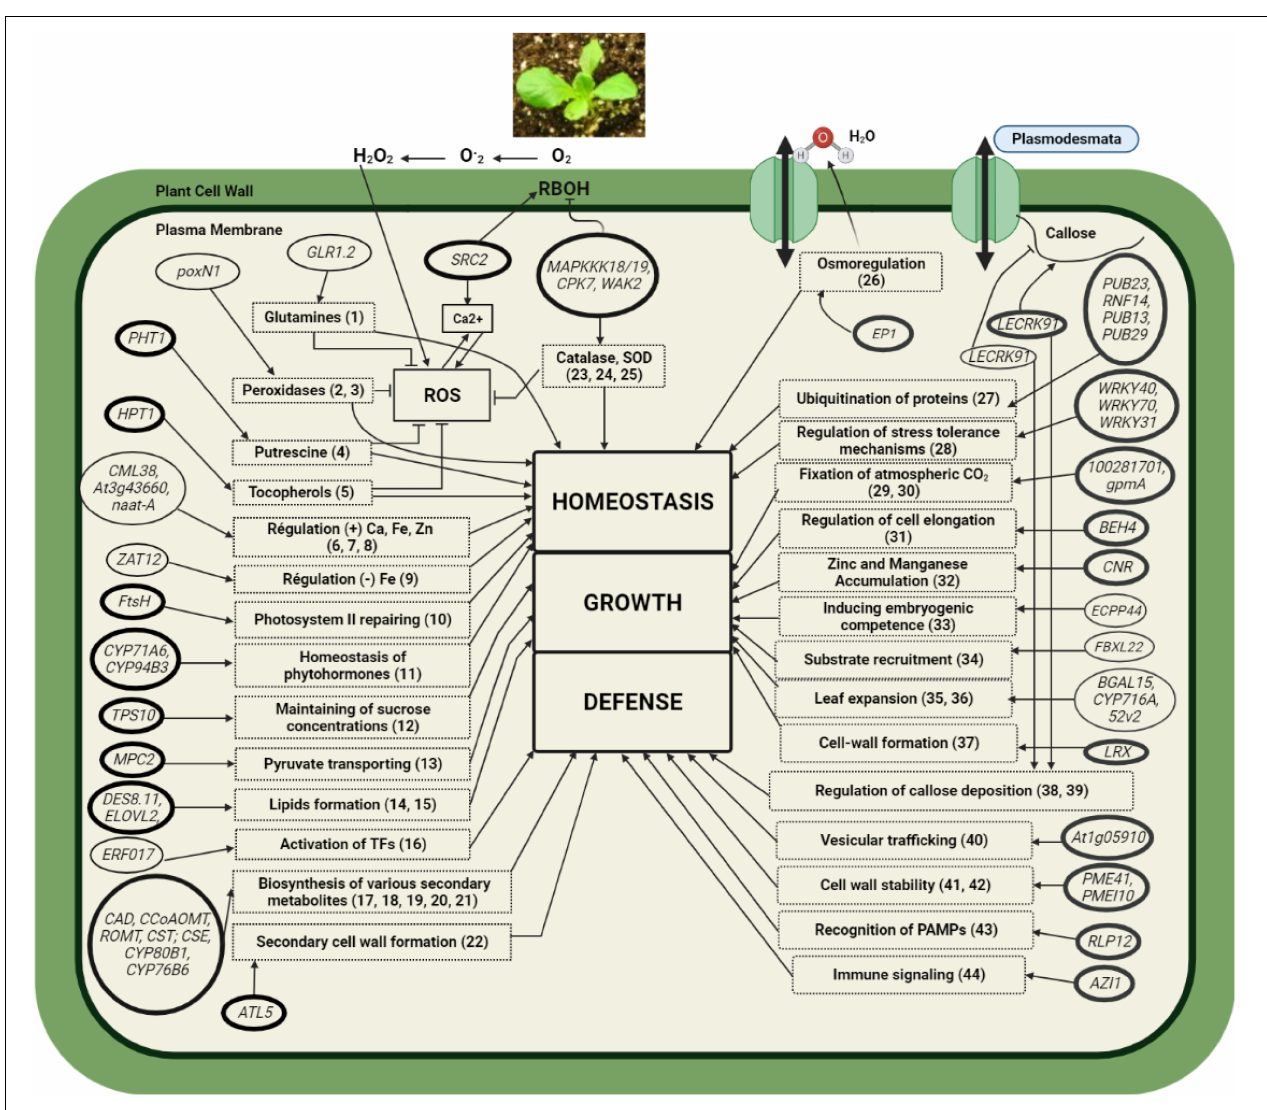
FIGURE 6 | Representative model of the regulation mechanisms induced in lettuce by the preharvest application of hormetic doses of UV-C and inoculation with the pathogen Xcv . Thick-bordered rectangular boxes: Physiological (or biological) processes; dashed rectangular boxes: Function or molecules associated with genes as reported in the literature. Thin-bordered ellipses: genes affected by UV-C alone; thick-bordered ellipses: genes affected by UV-C + Xcv infection. The pointed arrows indicate activation reactions and the blunt arrows indicate inhibition reactions. The numbers in brackets in the rectangular boxes represent the reference source(s). (1) Cheng et al. (2018); (2) Kim et al. (2007); (3) Wang et al. (2016); (4) Pushpa et al. (2014); (5) Savidge et al. (2002); (6) Lokdarshi et al. (2016); (7) Gollhofer et al. (2014); (8) Cassin et al. (2009); (9) Le et al. (2016); (10) Kato and Sakamoto (2018); (11) Yan et al. (2016); (12) Lunn et al. (2014); (13) Shen et al. (2017); (14) Doan et al. (2009); (15) Nayeri and Yarizade (2014); (16) Dey and Vlot (2015); (17) Zhang and Liu (2015); (18) Ma et al. (2005); (19) Ziegler and Facchini (2008); (20) Sung et al. (2011); (21) Höfer et al. (2013); (22) Noda et al. (2013); (23) Zhou et al. (2014); (24) Bundó and Coca (2017); (25) Li et al. (2020); (26) van Engelen et al. (1993);